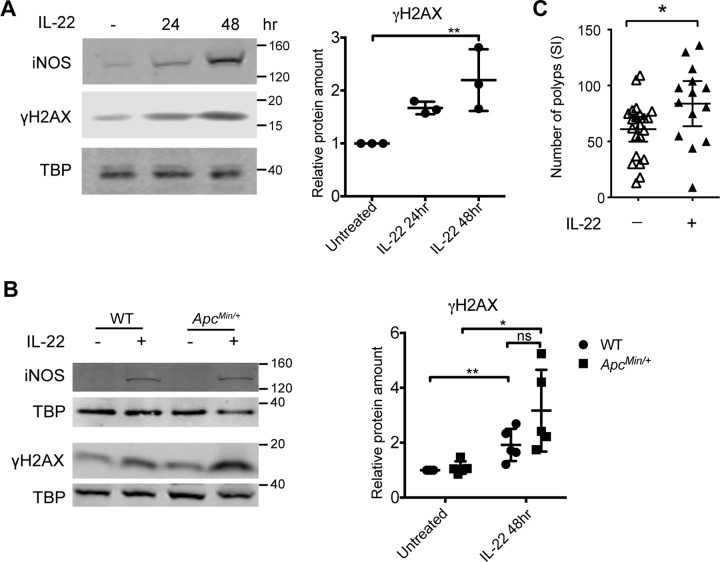
IL-22 increases iNOS and DNA damage in ApcMin/+ organoids.(A) Western blot of iNOS or γH2AX in WT organoids treated with IL-22 (10 ng/ml) for 24 or 48 hours. (B) Western blotting for iNOS or γH2AX in WT or ApcMin/+ organoids treated with IL-22 (10 ng/ml) for 48 hours. TBP was used as loading control. The ratio of γH2AX to TBP in each sample was normalised to untreated control in each experiment. At least 3 independent experiments were performed. *p < 0.05, paired t test. (C) ApcMin/+ mice aged 27–30 days were injected twice a week for 4 weeks with 1 μg IL-22 or PBS or were left untreated. Untreated and PBS-injected mice were pooled together for the “control” cohort (there was no difference in the tumour number in these two cohorts). *p < 0.05, unpaired t test. Numerical values for (A) and (B) are available in S1 Data. γH2AX, Phospho-Histone H2A.X (Serine 139); Apc, adenomatous polyposis coli; IL-22, interleukin-22; iNOS, inducible nitric oxide synthase; SI, small intestine; TBP, TATA box binding protein; WT, wild-type.